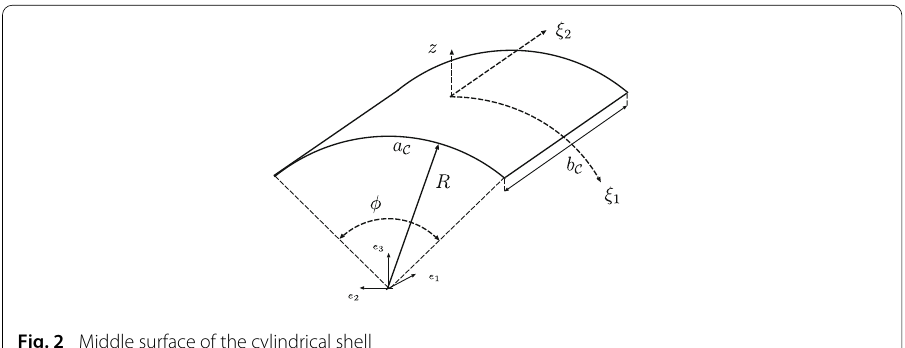
Fig. 2 Middle surface of the cylindrical